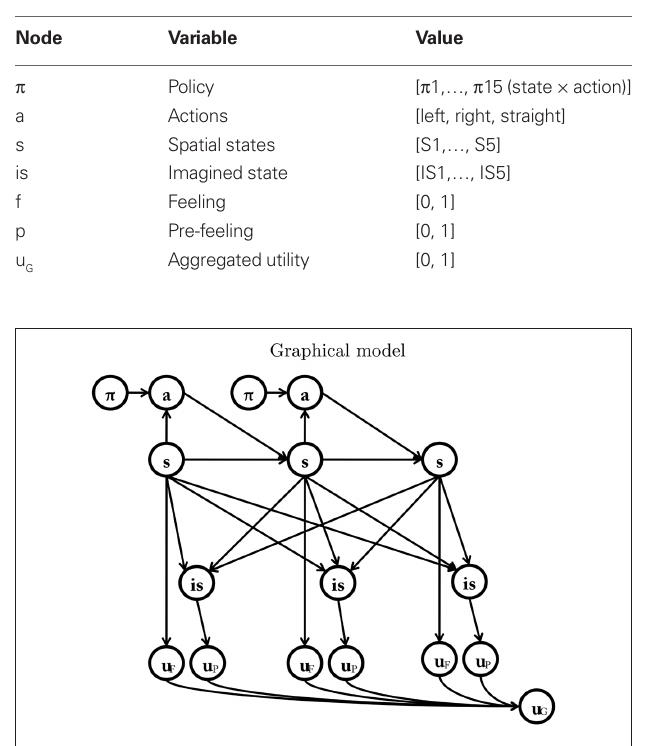
Figure 7 | Bayesian model of anticipated